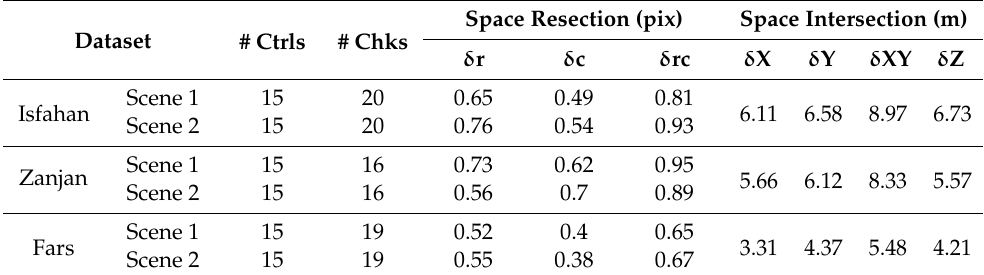
Table 3. Accuracy assessment of space resection and intersection of the stereo imagery.